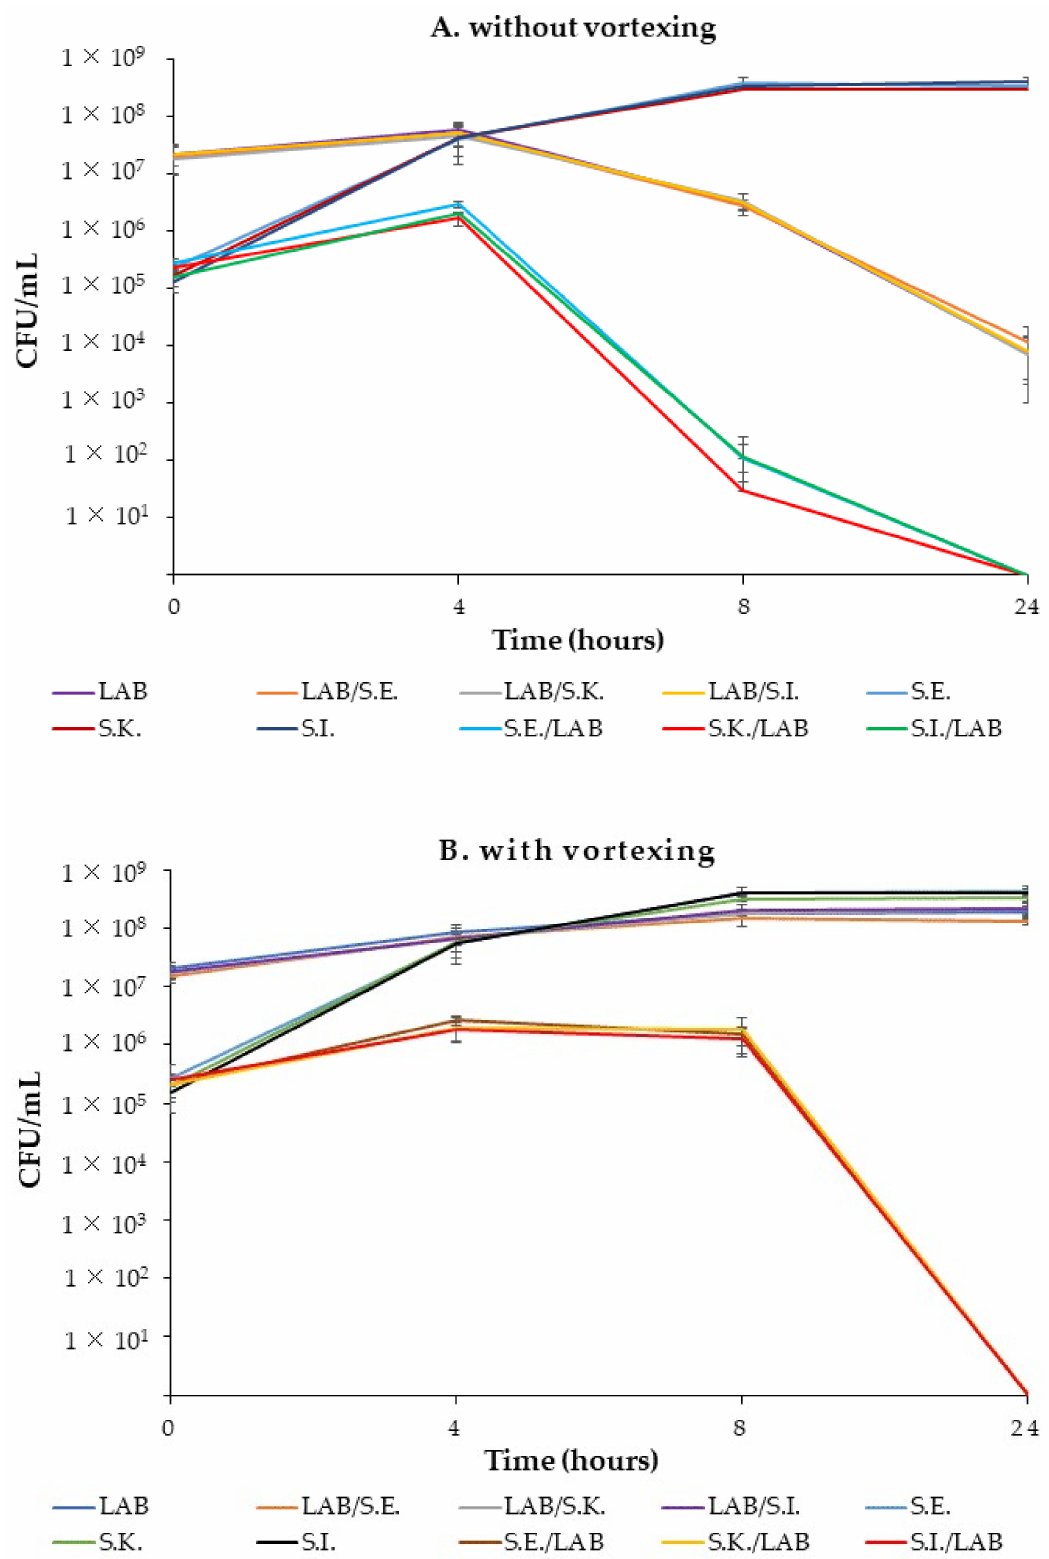
Figure 7. Kinetic growths of the pure cultures and co-cultures of Ligilactobacillus salivarius 16/c6 and S . Enteritidis, S . Infantis and S . Kentucky ST198 without ( A ) or with ( B ) vortexing. The means and standard deviations of the three independent experiments are shown, each with three